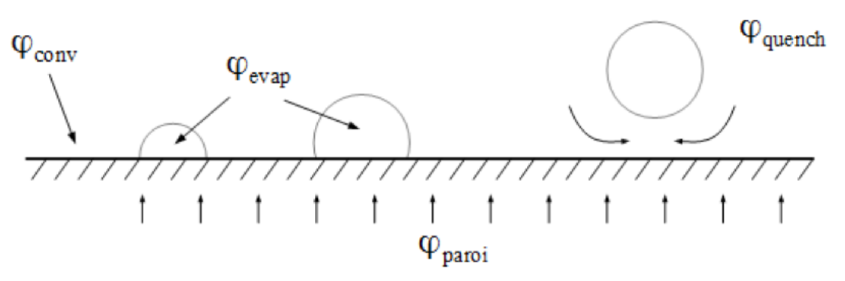
Figure 3. Parietal heat flux distribution diagram